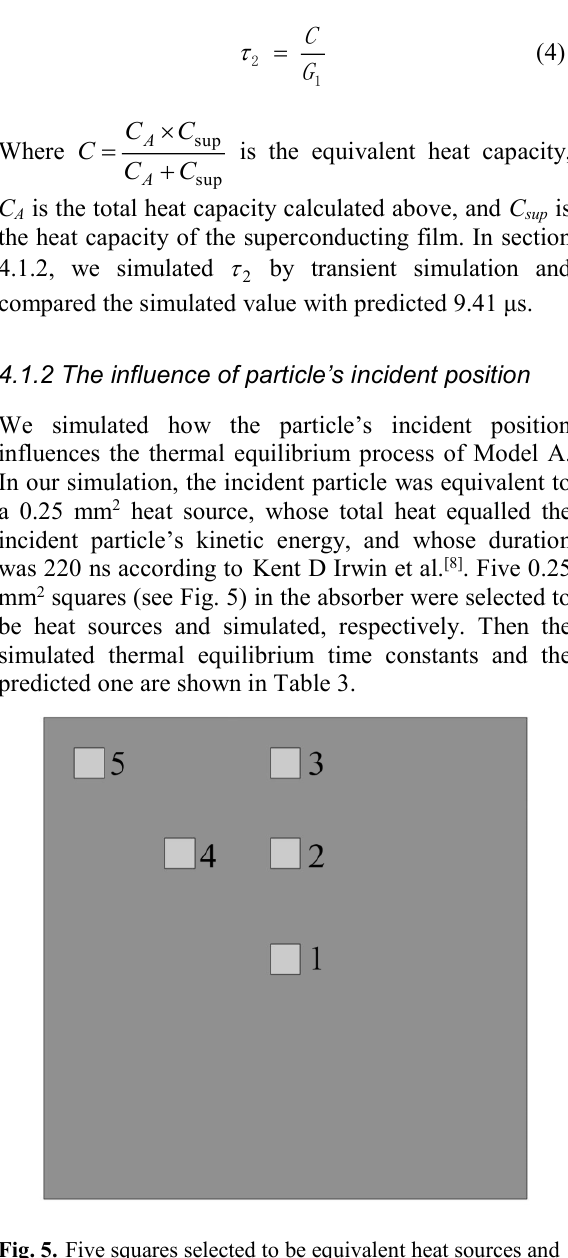
Fig. 5. Five squares selected to be equivalent heat sources and numbered by 1-5 . Table 3. Thermal equilibrium time constants simulated with different incident locations of particles and calculated.